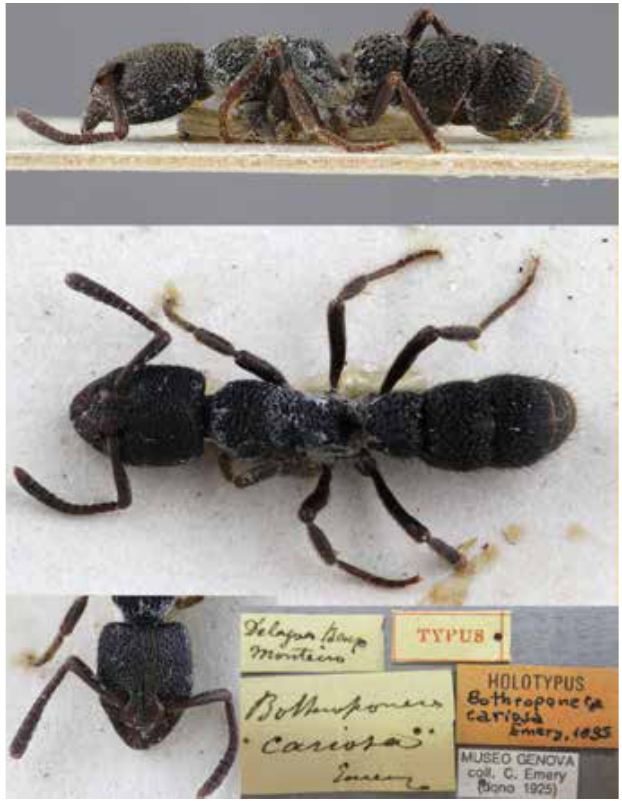
Plate 3 : Holotype worker of B. cariosa